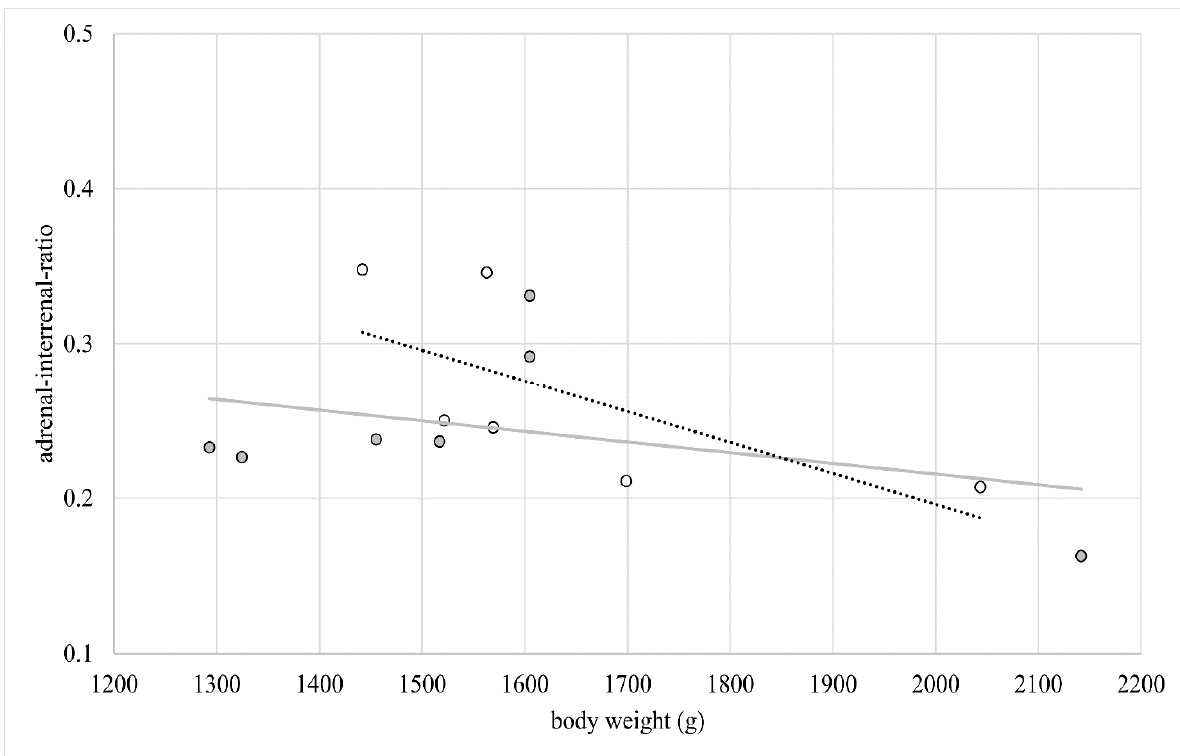
Figure 5. Correlation between body weight and adrenal–interrenal ratio ( n = 7 laying hens in single cages, grey dots; n = 6 laying hens in floor pens, white dots) Lines show the linear correlation between body weight and adrenal–interrenal ratio for SC (grey) and FP (black dotted).